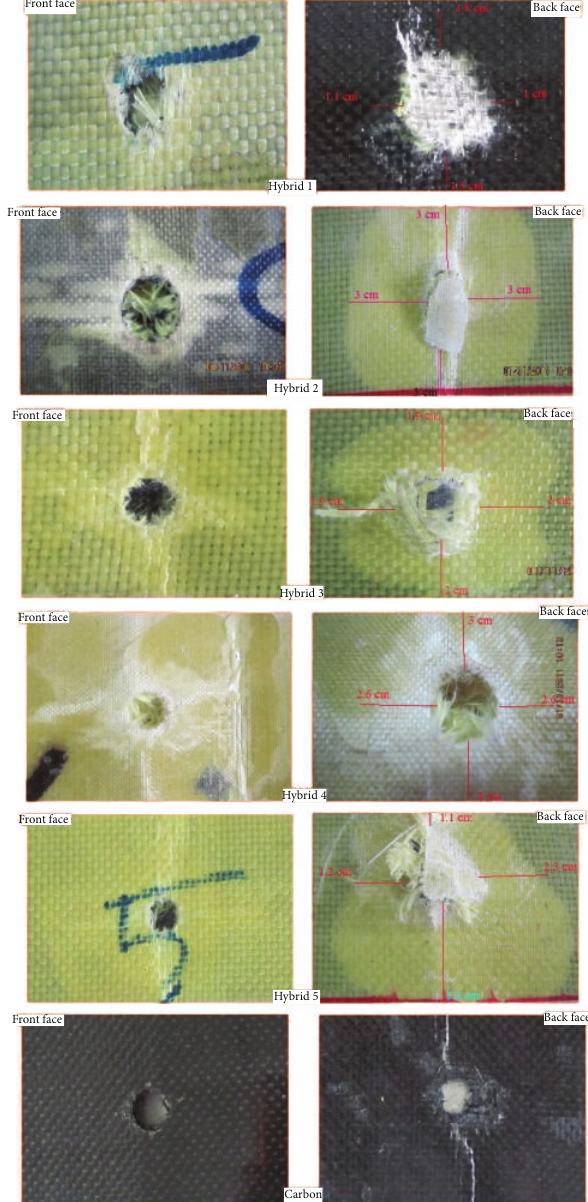
Figure 7: Postimpact images of damaged specimens’ profiles. (a) Impact-induced damage profile viewed from the front face and (b) impact-induced damage profile viewed from the back